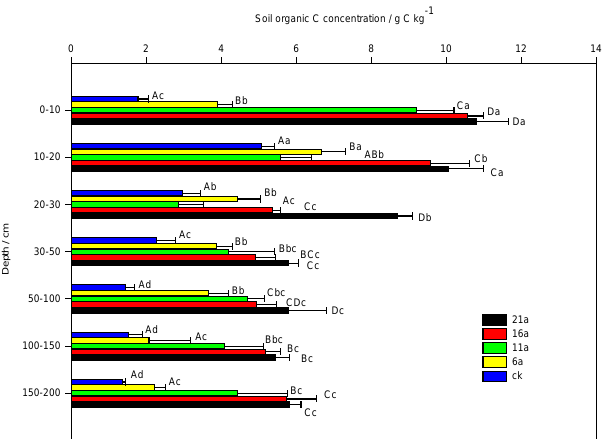
Figure 4. Variations in total nitrogen (total N) concentration at dif- ferent soil depths in different stand ages. Values are means ± SE. Different uppercase letters indicate significant differences in differ- ent stand ages; different lowercase letters indicate significant differ- ences at different soil depth ( P <0.05).